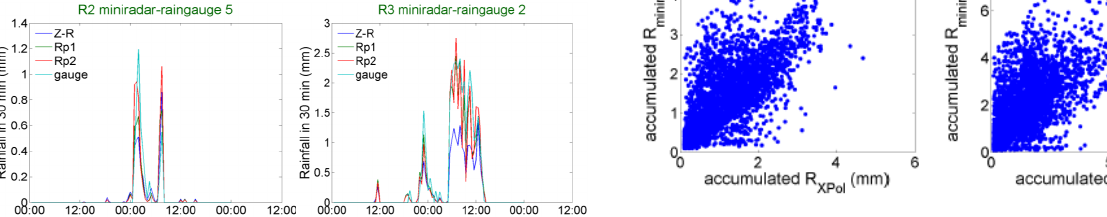
Figure 12. Histograms of difference between mini-radars (R3 on the left and R2 on the right) and XPol estimates of total rainfall accumulated during the rain event of Sept. 8, 2001 using the three retrieval algorithms of Eqs. (1)-(3).